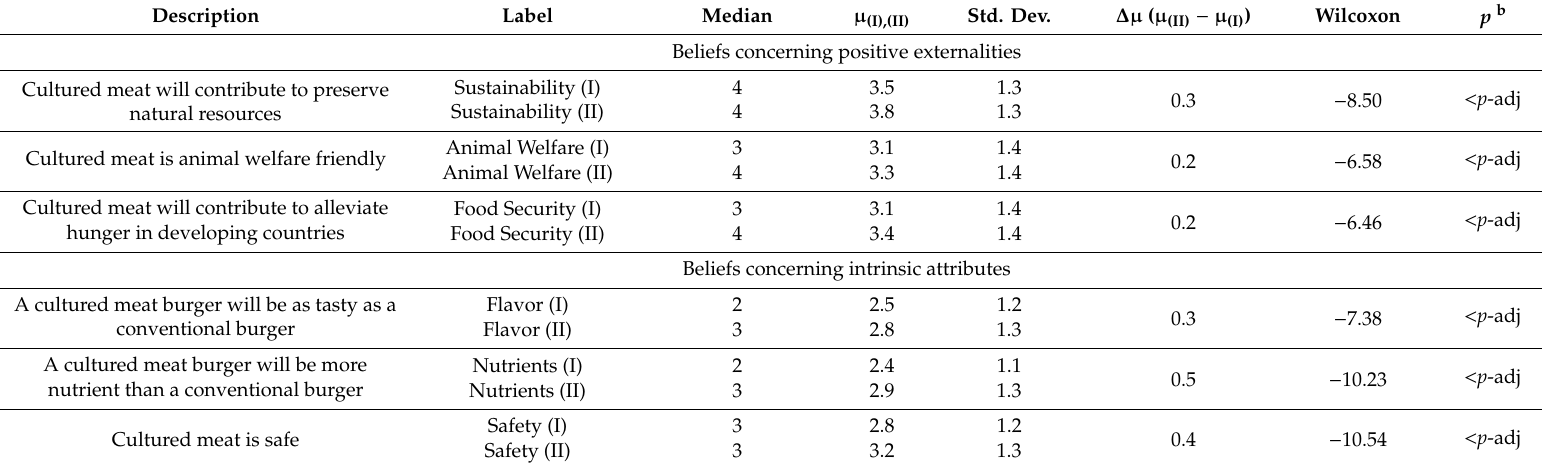
Table 1. Beliefs concerning positive externalities and intrinsic attributes a